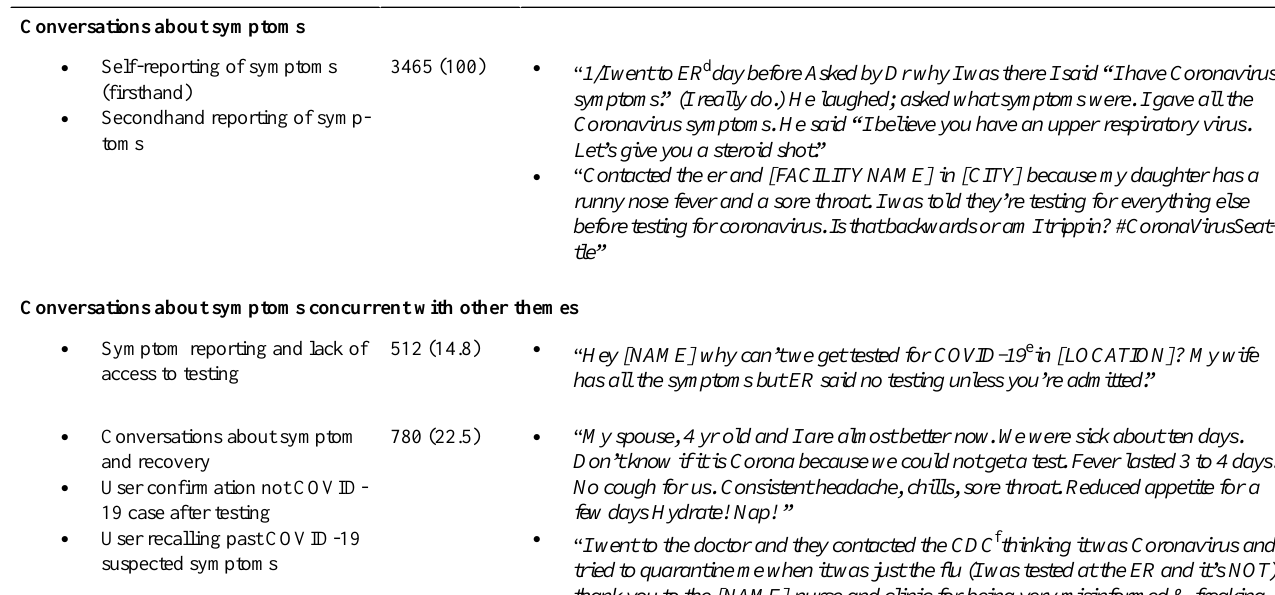
Example conversation c Posts, n (%) b Theme